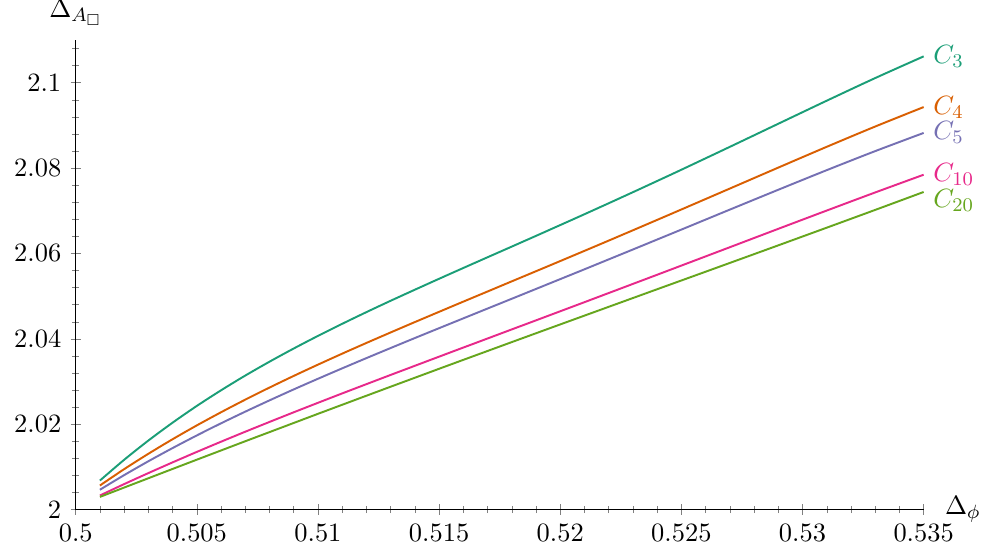
sector of the (cid:30) i (cid:2) (cid:30) j (cid:3)